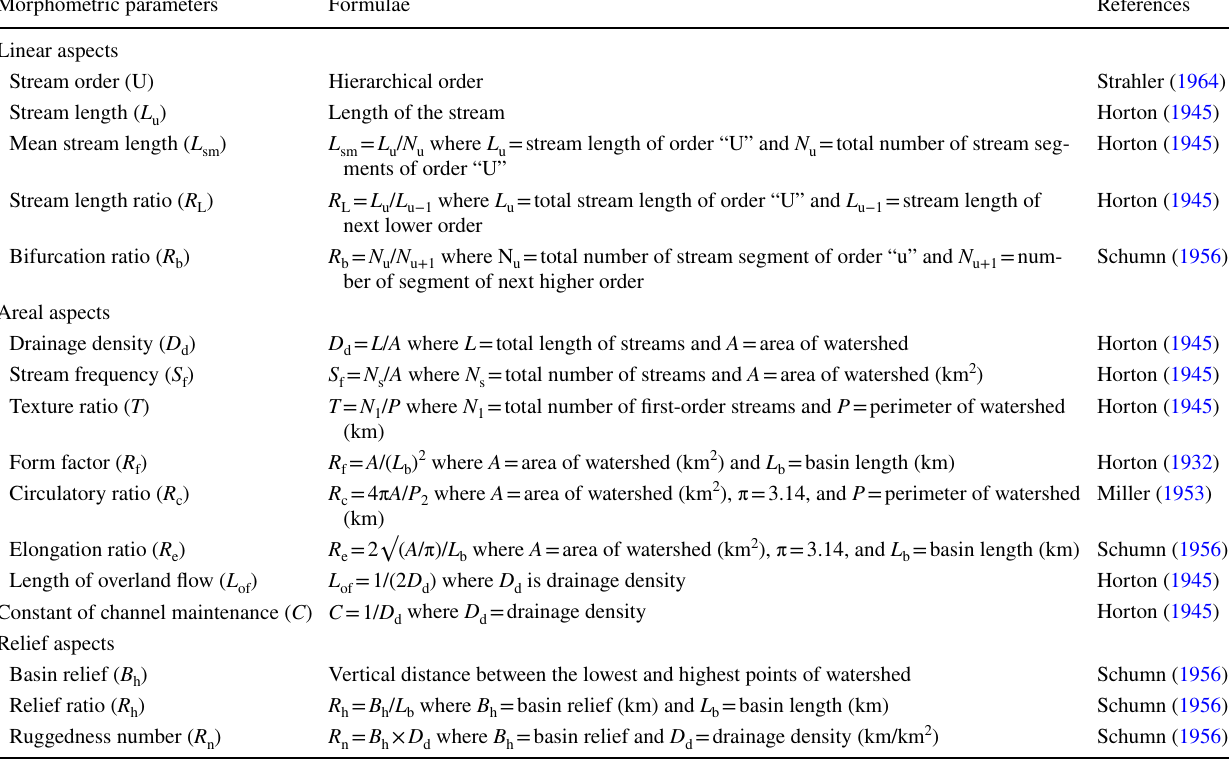
Table 2 Formulae for estimation of morphometric parameters of Arkavathy basin Morphometric parameters